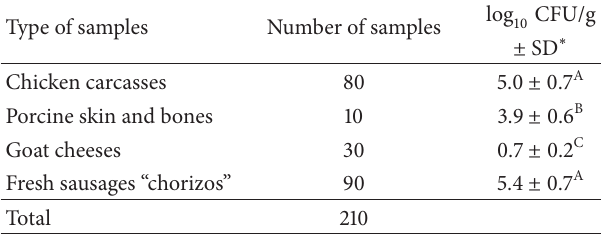
Table 1: Counts of total coliforms in samples of animal origin purchased at retail markets and intended for human